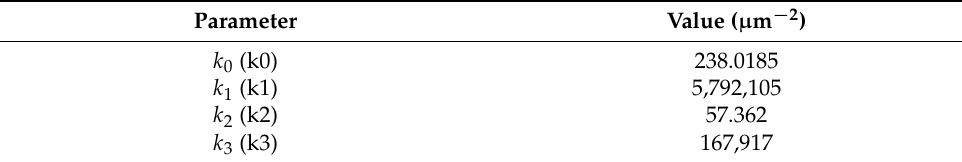
Table 2. Constants for variation of refractive index; see Equation (2).